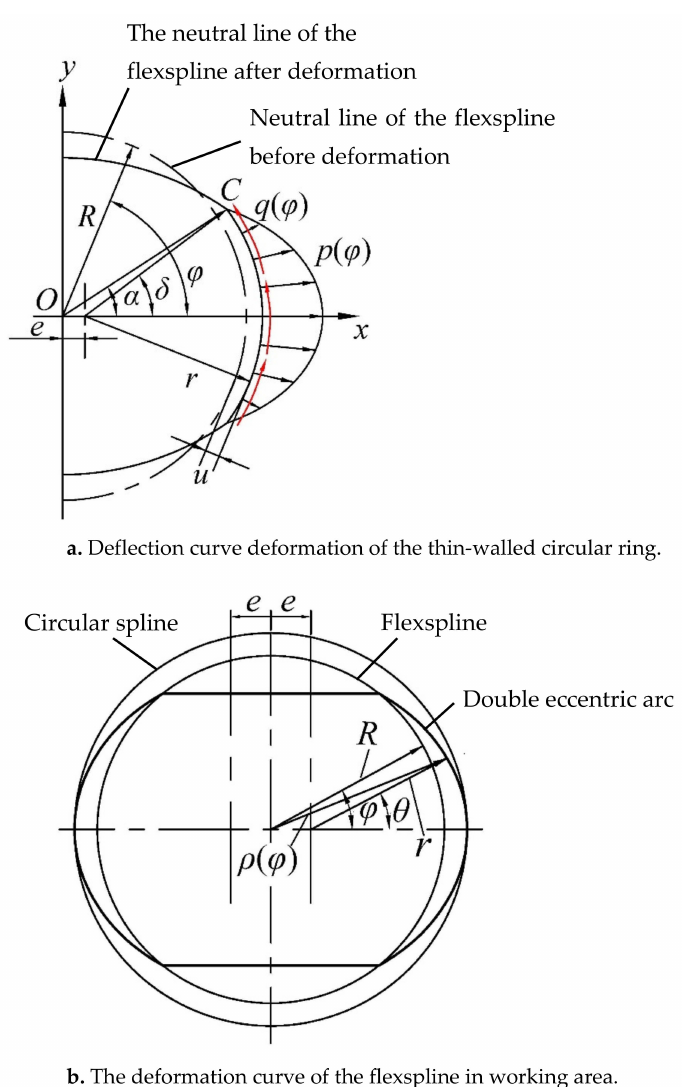
Figure 4. Cam wave generator design in a new deformation